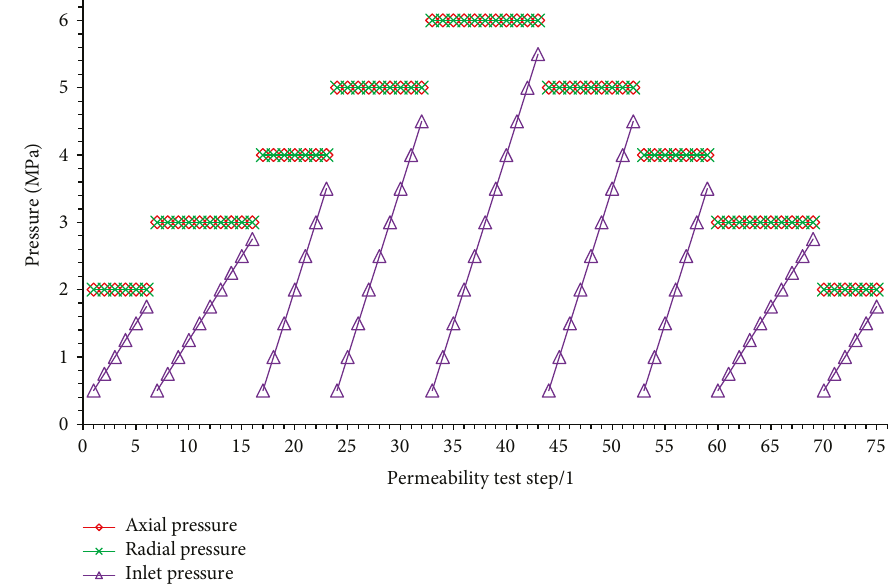
Figure 3: Tests on the pore pressure e ff ect on the permeability under constant con fi ning pressure.